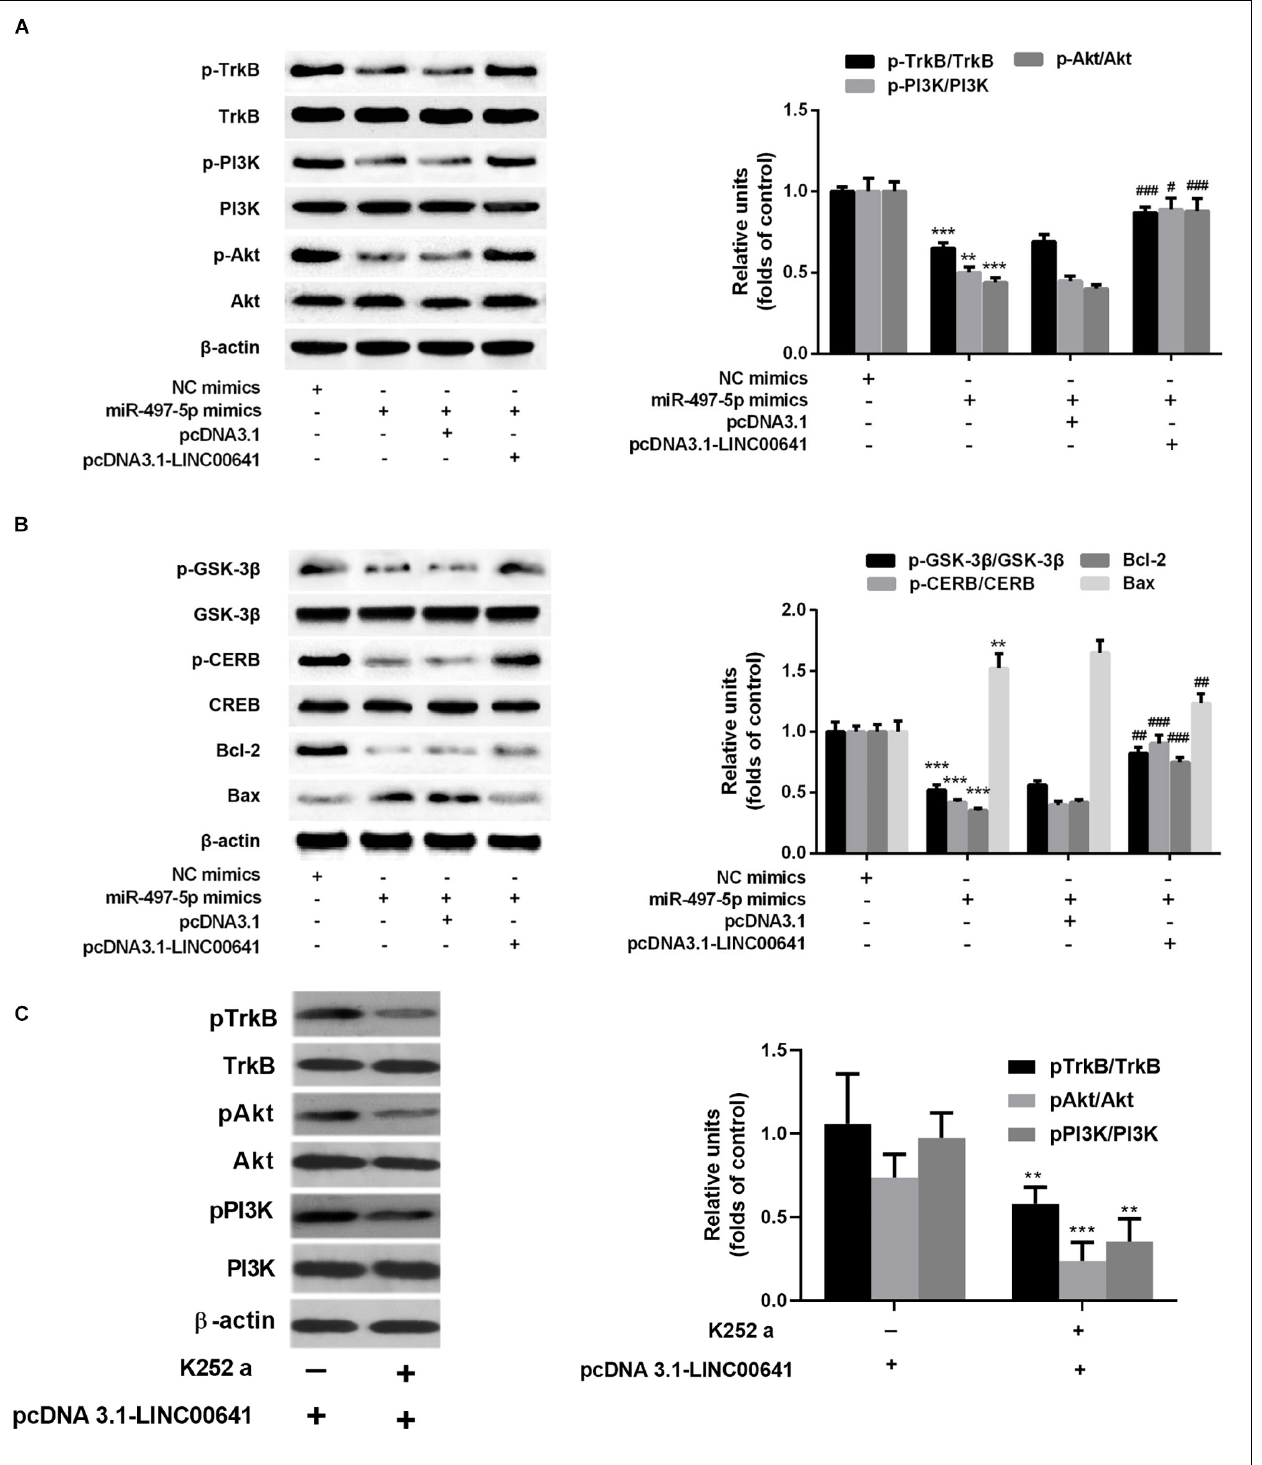
FIGURE 5 | LINC00641 ameliorated ketamine-induced neurological injury by activating the TrkB/PI3K/Akt signaling pathway. (A) Western blot was used to detect the expression variable of p-TrkB, p-PI3K and p-Akt protein and the expression of relative protein after miR-497-5pmimics was added to LINC00641 cell line. (B) Protein expression and relative protein expression levels of apoptosis-related proteins p-GSK-3 β , p-CERB, Bcl-2, and Bax in miR-497-5p mimics were added to the overexpressing LINC00641 cell line. (C) The LINC00641-overexpressed cell line was treated with TrkB inhibitor (K-252a, 1.7 nM), and Western blot was used to detect p-TrkB, p-PI3K, and p-Akt expression of relative protein. * P < 0.05, ** P < 0.01, and *** P < 0.001 vs. NC mimics group. # P < 0.05, ## P < 0.01, and ### P < 0.001 vs. miR-497-5p mimics + pcDNA3.1 group.